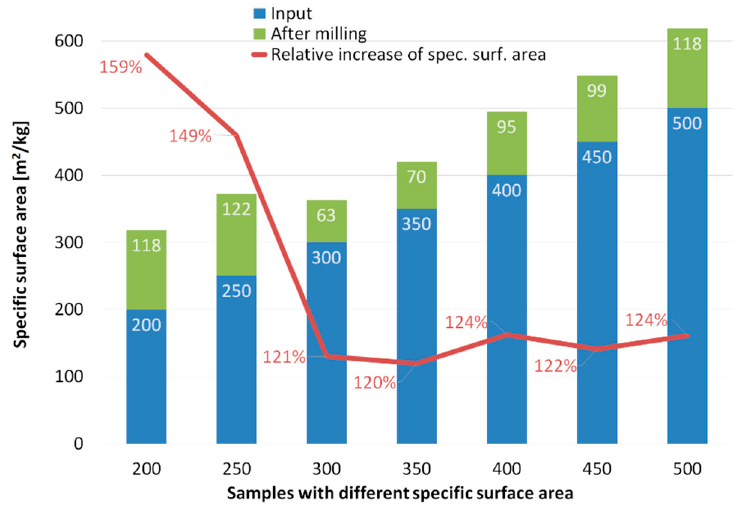
Figure 3. Increase in specific surface area for all ground samples.